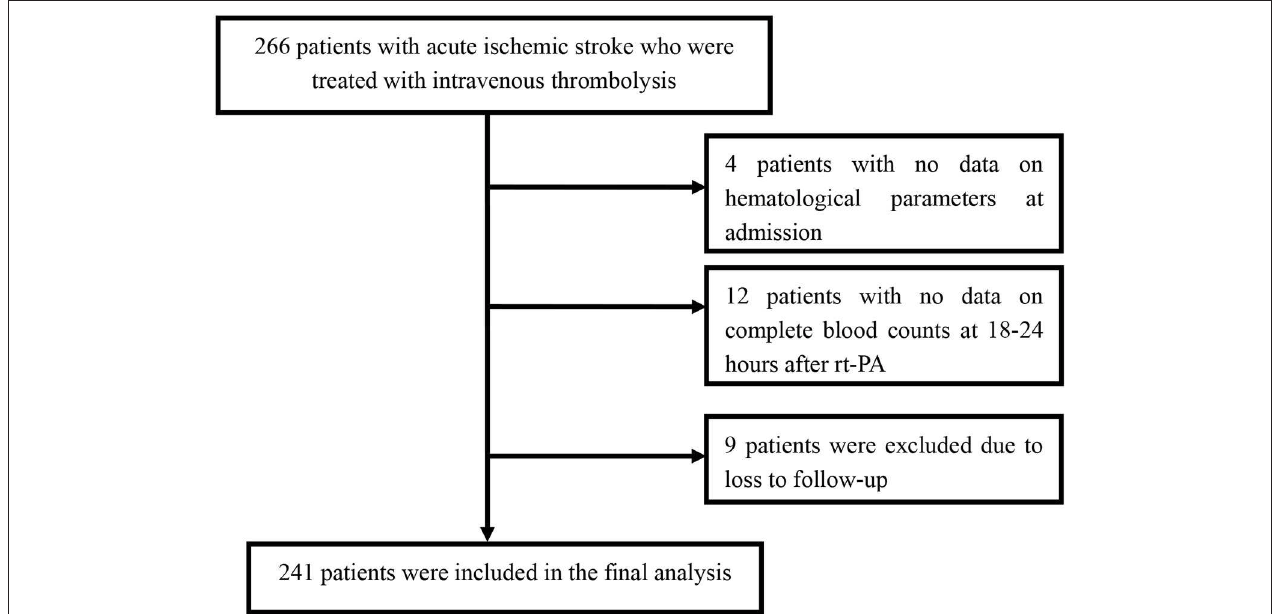
FIGURE 1 | Flow diagram showing the patient selection